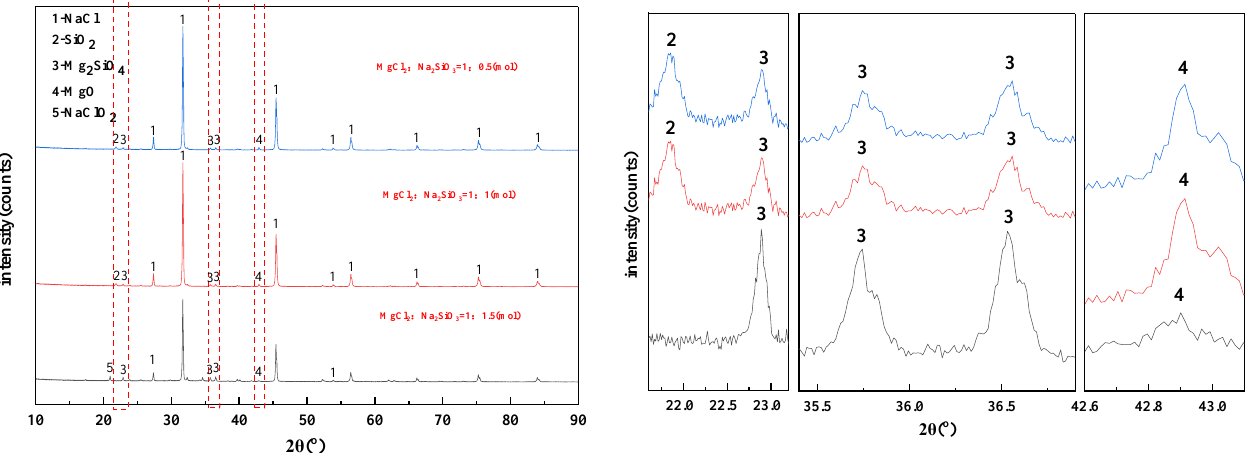
Figure 9. XRD of filter residues obtained with different dosage of additives.